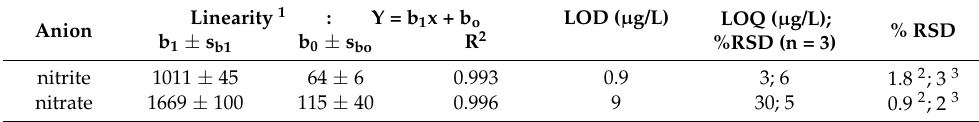
Table 3 . Analytical parameters obtained with the proposed method IT-SPME-IE-CapLC-DAD. Table 3. Analytical parameters obtained with the proposed method IT-SPME-IE-CapLC-DAD.